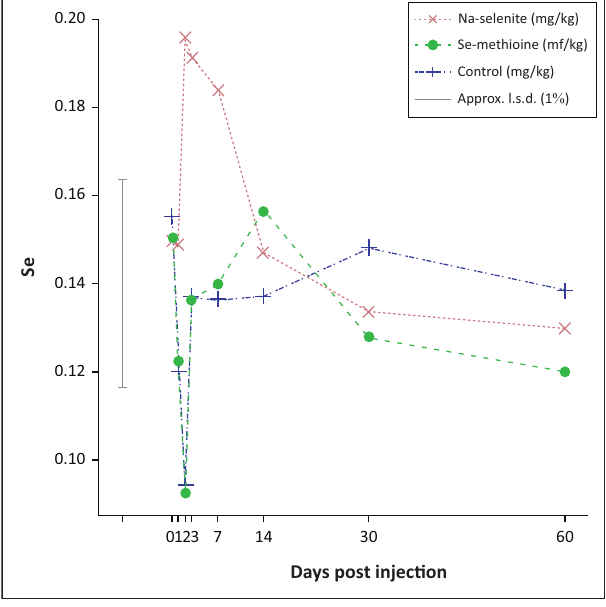
FIGURE 1: Mean somatic cell count (×10 3 cells/mL milk) over time post selenium injection.